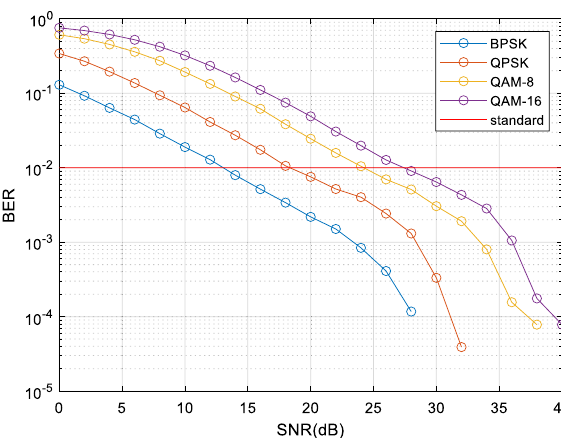
Fig. 9 Simulation of different modulation modes of OFDM system in multi-path fading